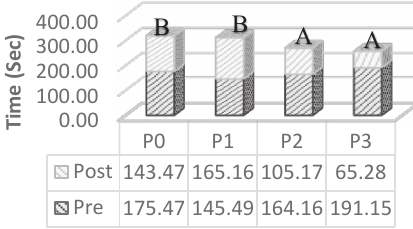
Figure 3. White tea intervention in the rats ’ immobility test (Different subset (A/B)meanstatistically difference p <